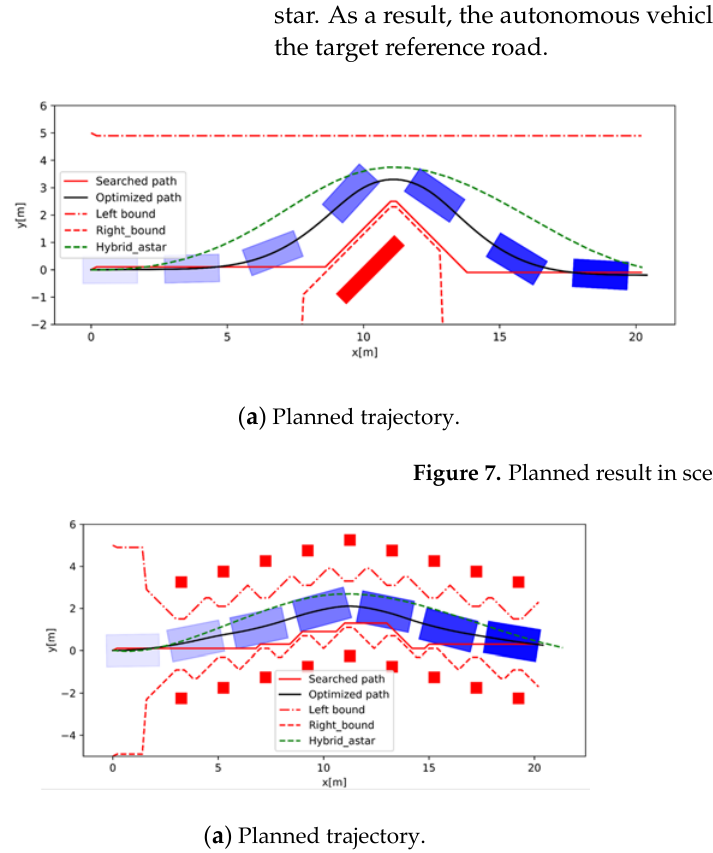
Figure 7. Planned result in scenario 1.